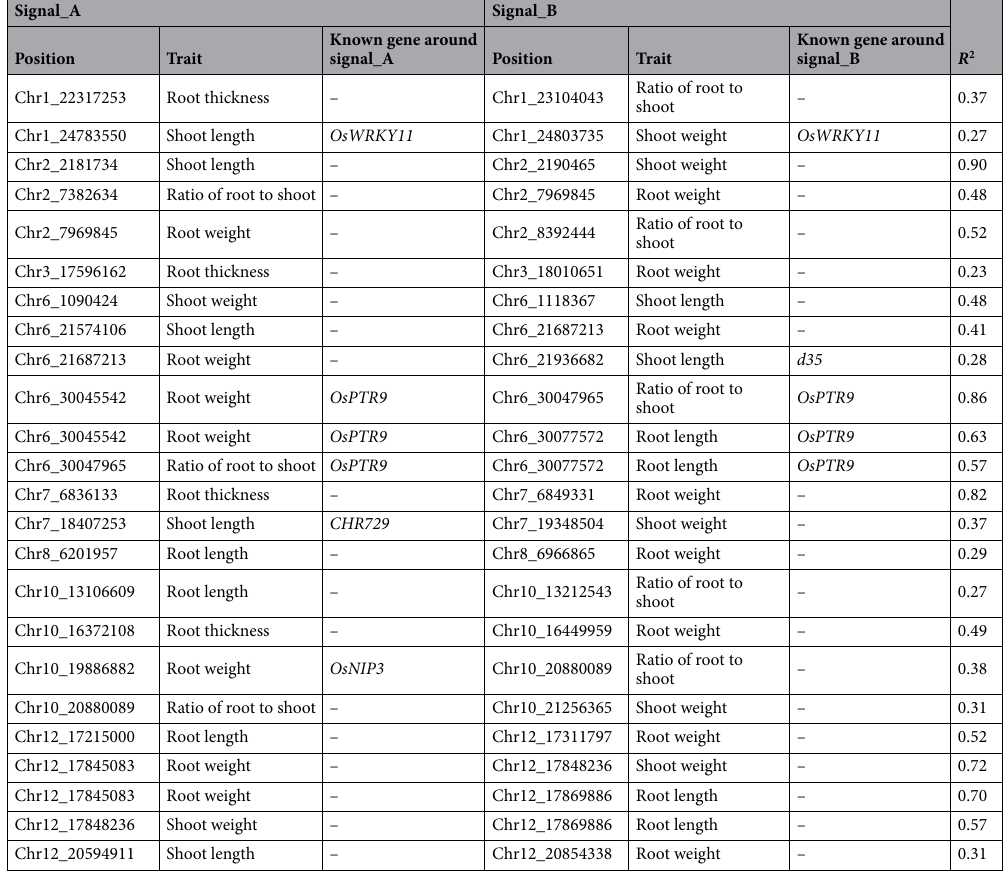
Table 1. Twenty-four pairs of association signals for different rice biomass traits with strong LD.